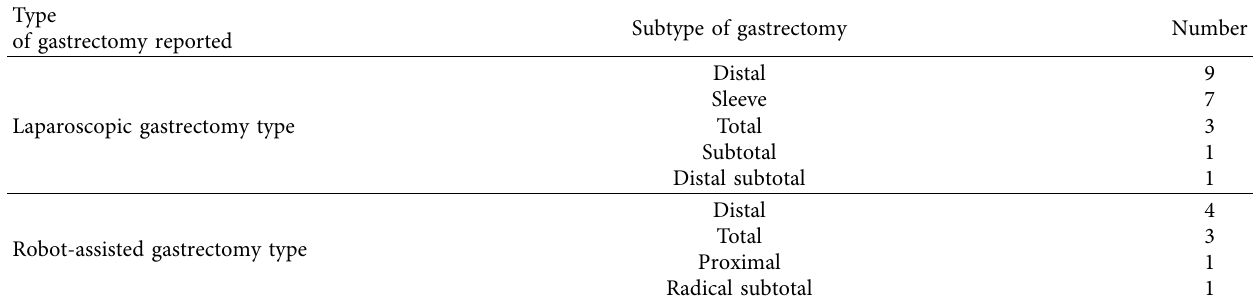
Table 4: Types of gastrectomy procedures reported for SIT patients in the literature.